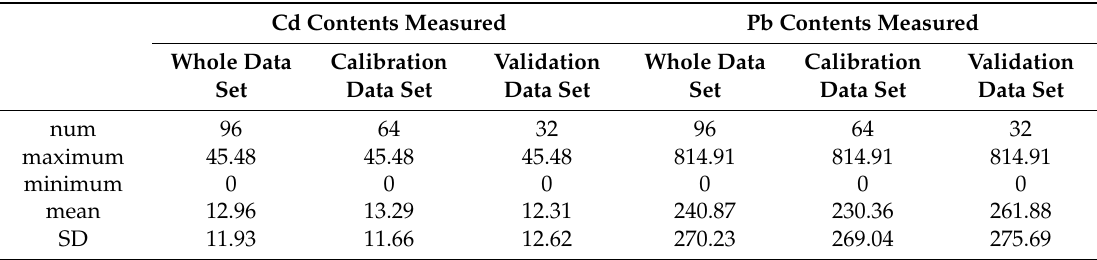
Table 2. Statistical Description of the leaf Cadmium-Lead(Cd–Pb ) Contents (mg kg-1) for the whole data sets, calibration datasets, and validation data sets.